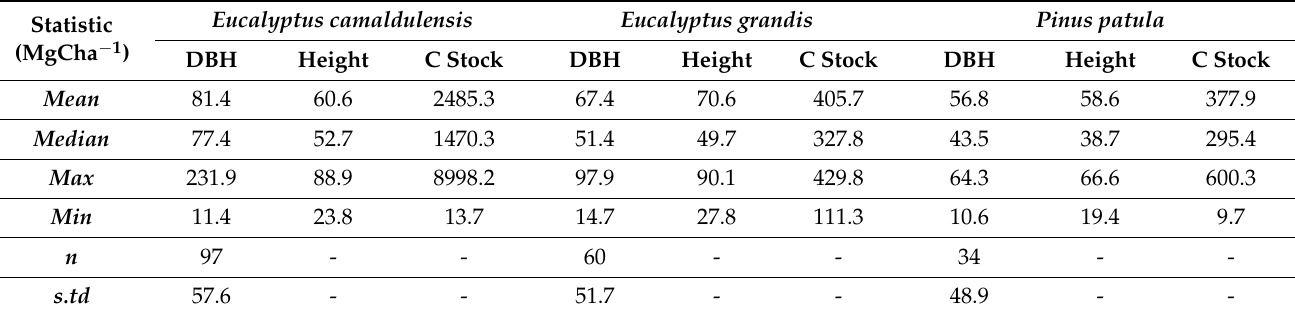
Table 1. Summary statistics of the measured C stock plantation forest